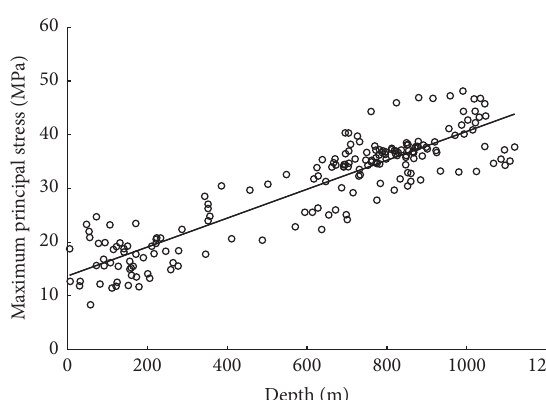
Figure 10: Relationship between the maximum principal stress and the buried